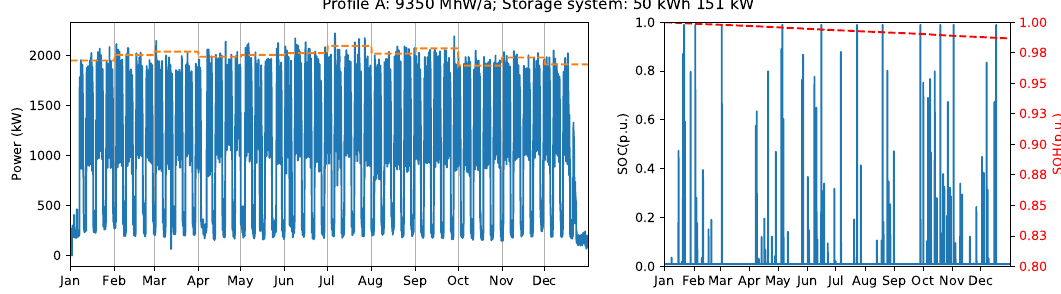
Figure 6. Industrial load profile A with yearly billing scheme ( left ), and battery state of charge and state of health ( right ).